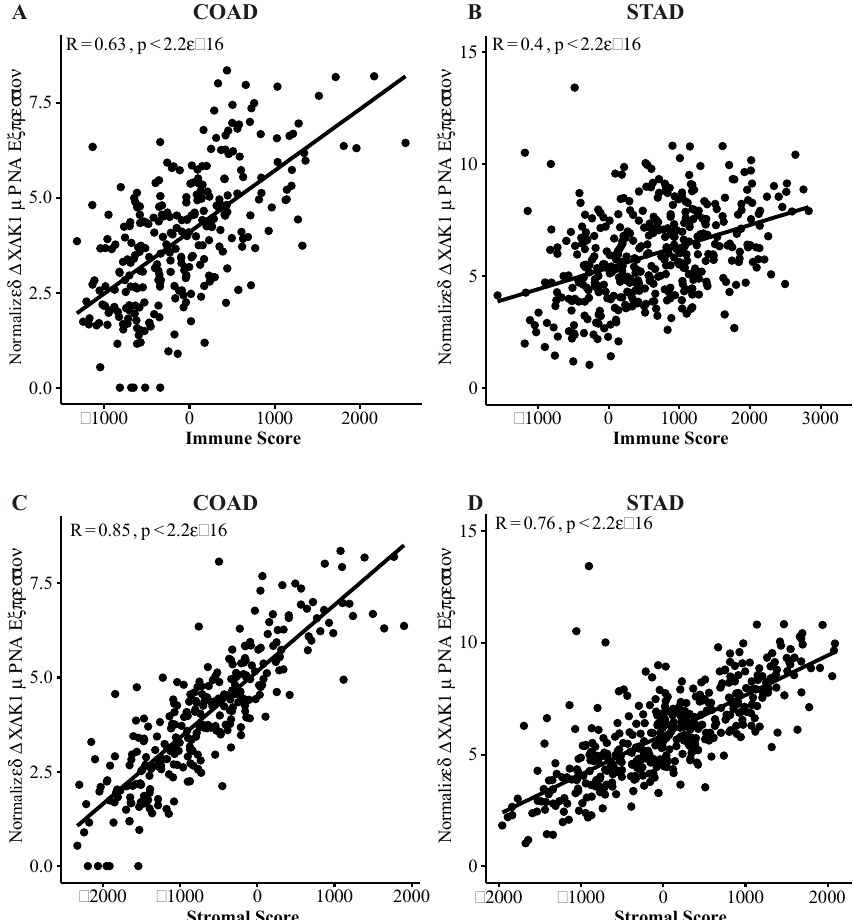
Figure 2. DCLK1 is correlated with an activated tumor microenvironment (TME) in COAD and STAD. DCLK1 mRNA expression is strongly associated with Immune Score and Stromal Score in COAD ( A and C ) and STAD ( B and D ) based on Pearson correlation analysis.